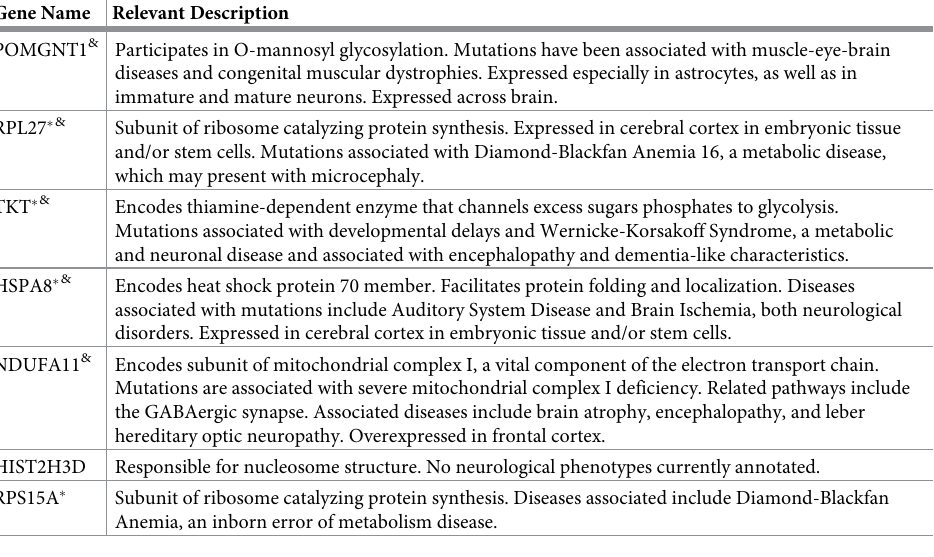
Table 1. Translationally down-regulated genes during acute Tm treatment with restored regulation during Tm + ISRIB treatment. Gene Name Relevant